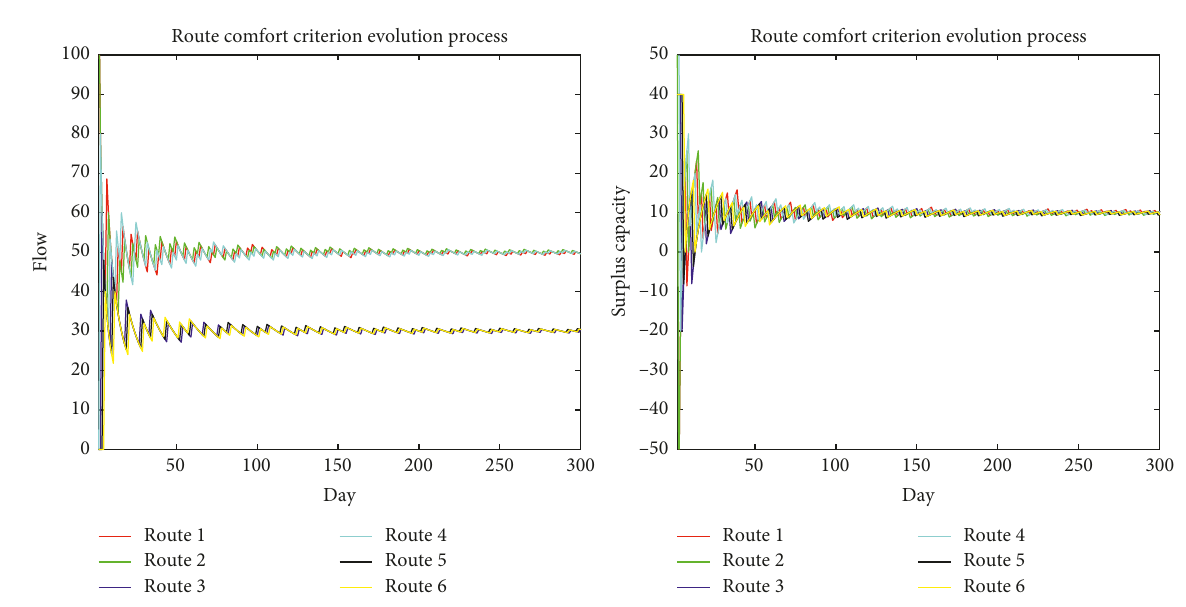
Figure 4: Evolutionary trajectories of route